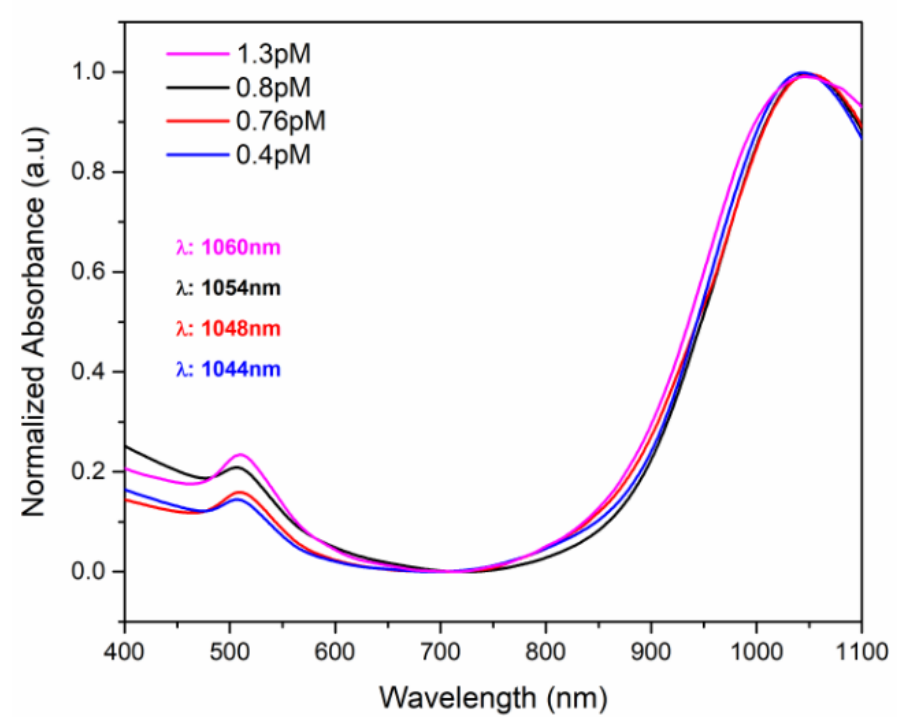
Figure 15. UV-Vis NIR-II spectra of the ICs associated with the AuNRs.